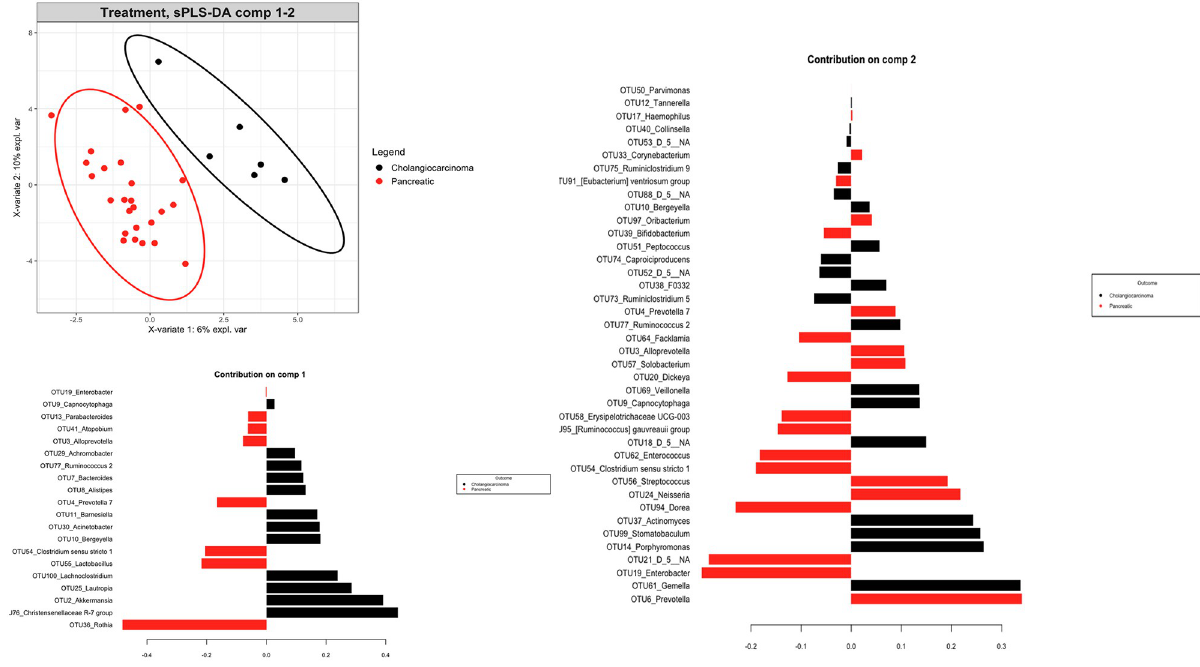
Fig 7. Multivariate analysis and diversity of biliary microbiota in patients with pancreatic cancer versus cholangiocarcinoma using mixMC.